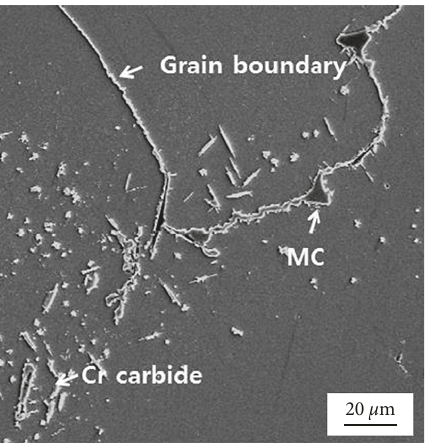
Figure 2: Scanning electron microscopy (SEM) image of cast Haynes 282 after ageing for